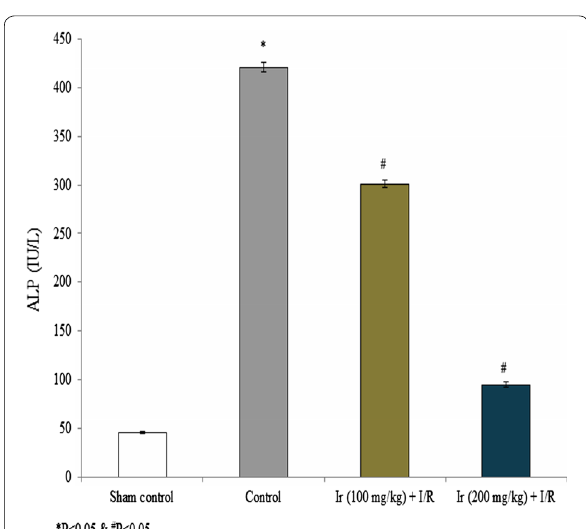
Fig. 4 Ir attenuated serum ALP enzyme level. Values are expressed IU/L. Results are shown mean with SEM. N group, # P < 0.05 vs. treated groups